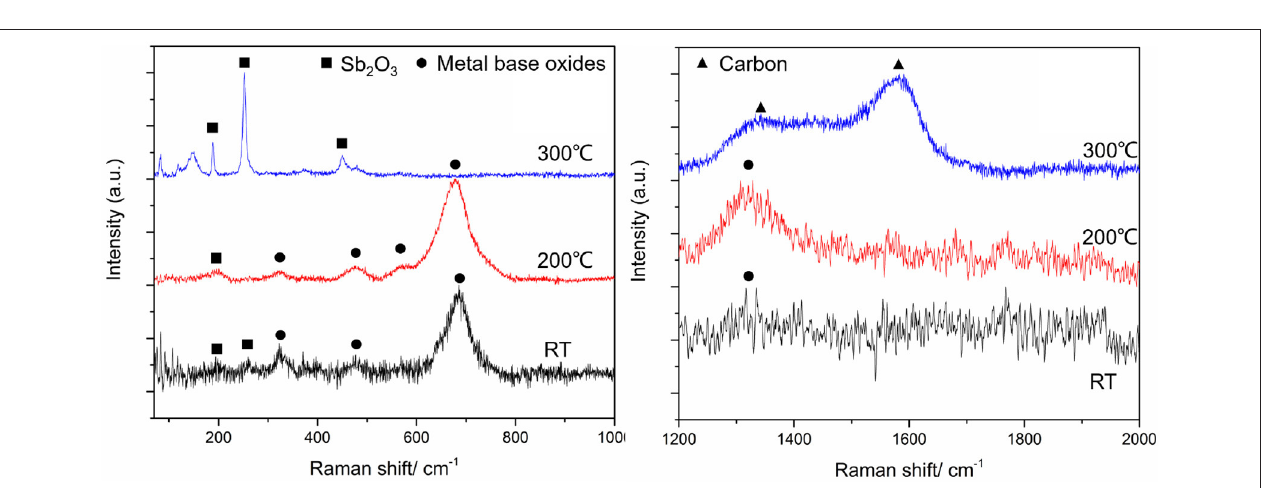
MSH/C could present the best performance under 300 ◦ C since the heat conduction energy will make up for the lack of friction